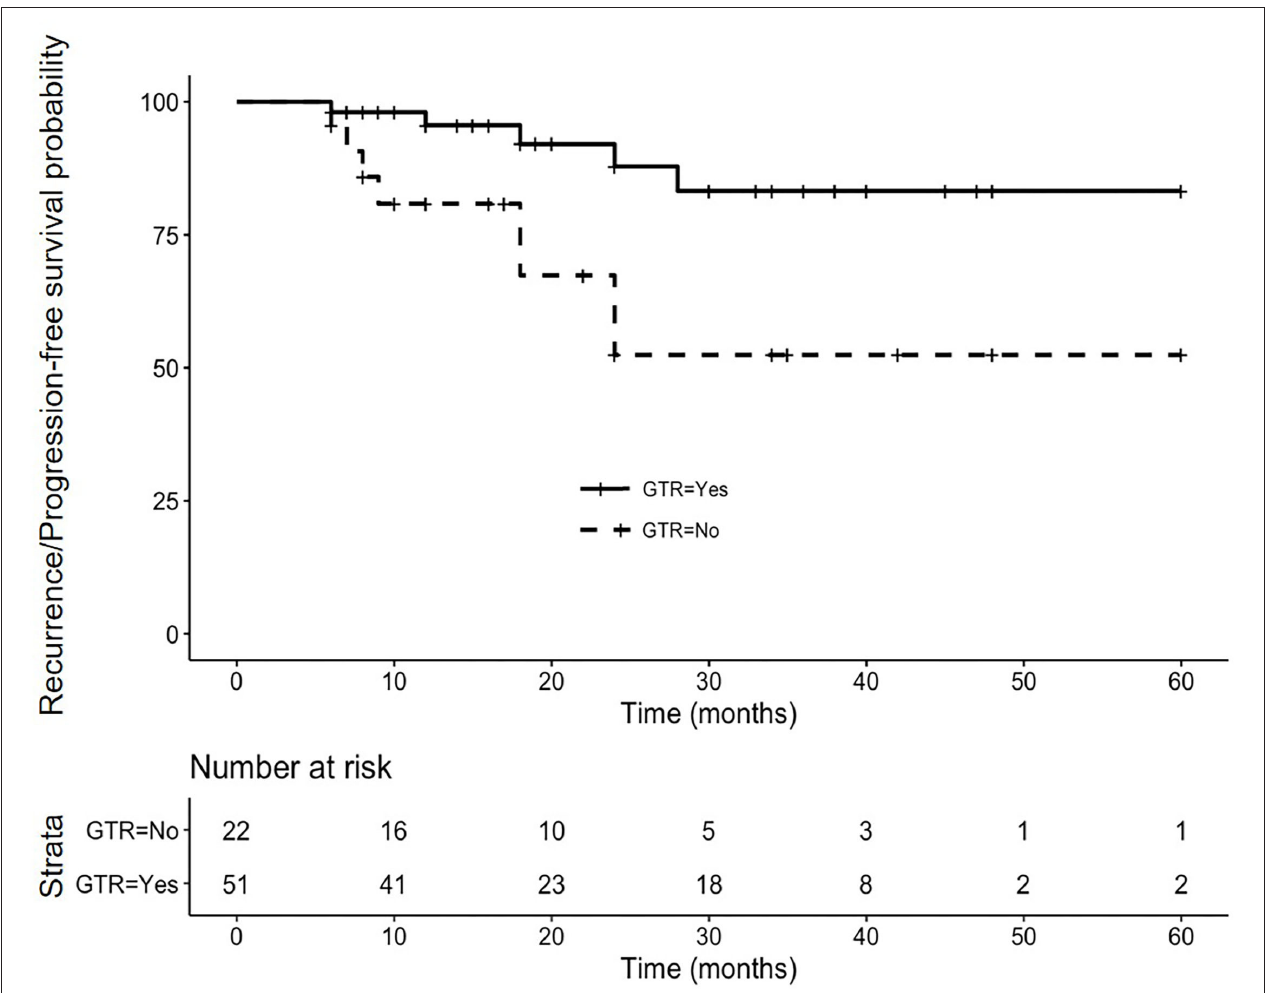
FIGURE 1 | Cumulative recurrence/progression-free Kaplan-Meier curve in 73 suprasellar craniopharyngiomas underwent endoscopic endonasal surgeries. The mean recurrence/progression-free survival time was 53 (95% CI 48–59) and 39 (95% CI 28–50) months, respectively, in patients with (the solid line) and without (the dotted line) gross total resection ( p =